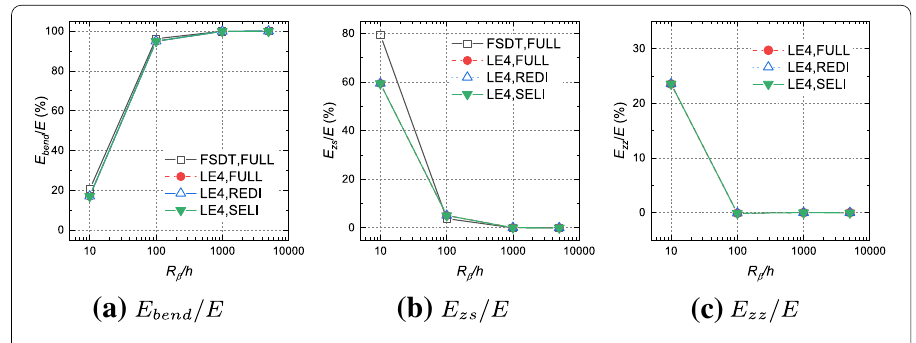
Fig. 16 Ratio of different energy components versus radius-to-thickness ratio on the three-layered cylindrical panel under